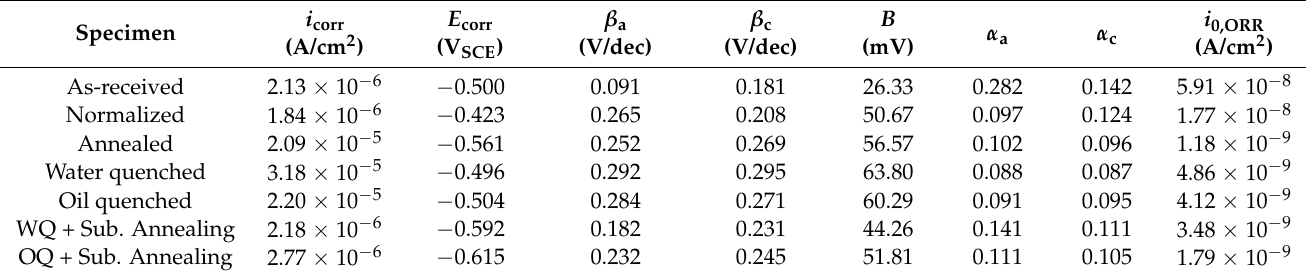
Table 2. E corr and i corr parameters obtained via CPP of CS samples in FA pore solution (pH